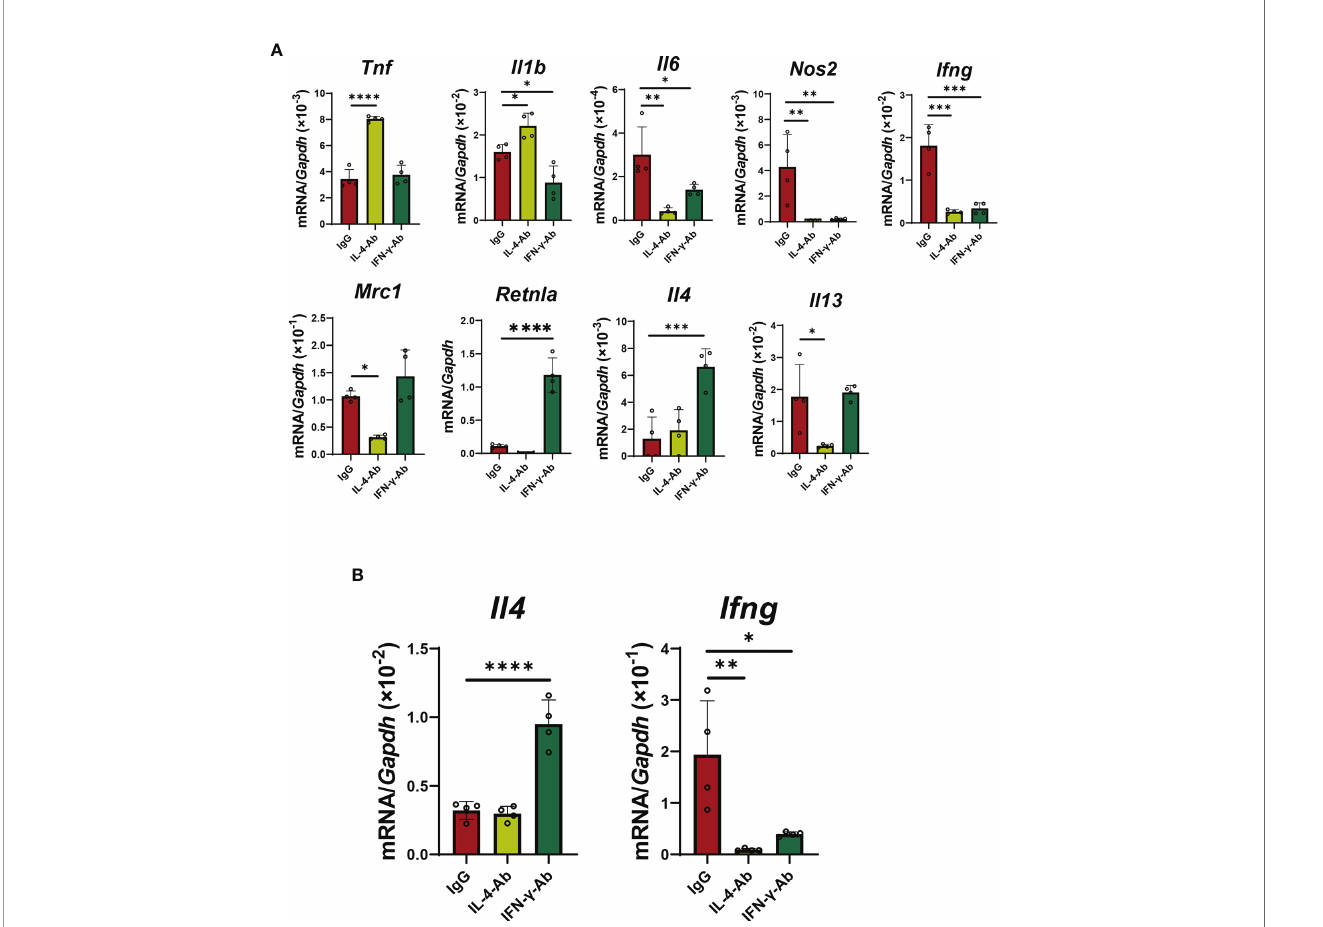
FIGURE 6 | Effects of blockade of IL-4 or IFN- g on macrophage differentiation and cytokines production from iNKT cells. (A) The levels of mRNA encoding genes related to a pro-in fl ammatory macrophage phenotype ( Tnf, Il1b, Il6, Nos2, and Ifng ) and genes related to a reparative macrophage phenotype ( Mrc1, Retnla, Il4, and Il13 ) in macrophages co-cultured with iNKT cells. Macrophages co-cultured with iNKT cells in the presence of a -GalCer were incubated for 72 h with an IL-4- (5 m g/ mL) or IL-13-neutralizing antibody (5 m g/mL). Data are expressed as the mean ± SD (four mice per group, representative data from two independent experiments). * P < 0.05, ** P < 0.01, *** P < 0.001, **** P < 0.0001. (B) The levels of mRNA for Il4 and Ifng from iNKT cells. NKT cells co-cultured with macrophages in the presence of a -GalCer were incubated for 72 h with IL-4 (5 m g/mL) or IL-13 neutralizing antibody (5 m g/mL). Data are expressed as the mean ± SD (four mice per group, representative data from two independent experiments). * P < 0.05, ** P < 0.01, **** P <